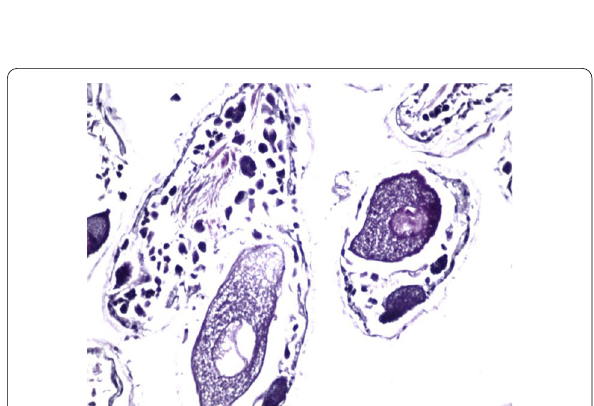
Fig. 4 Showed ovotestis of treated M. vermiculata with sodium benzoate. There was no histopathological alteration in the ovarian structure while the spermatozoa showed diminished concentration